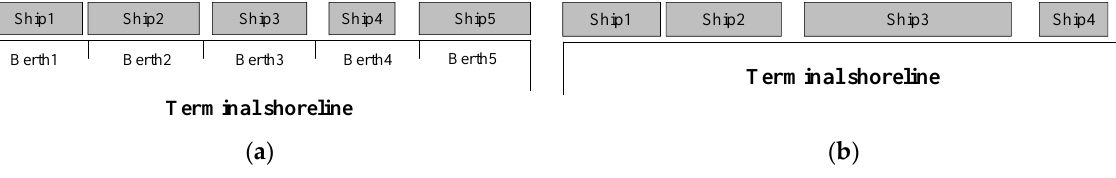
Figure 4. Schematic diagram of discrete and continuous berths. ( a ) Discrete berths; ( b ) Continuous berths.